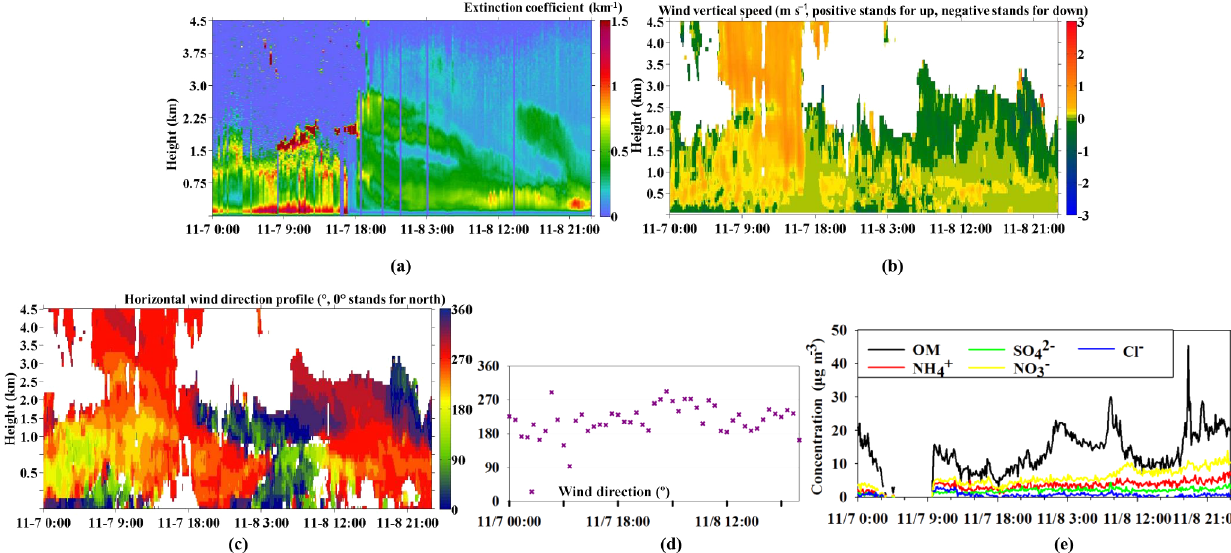
Figure 9. Characteristics of particulate matters and meteorological parameters at the Liulihe site during episode 3. (a) Vertical profile of extinction coefficient, (b) vertical profile of wind vertical direction and speed, (c) horizontal wind direction profile, (d) wind direction on the ground, (e) NR-PM 1 chemical